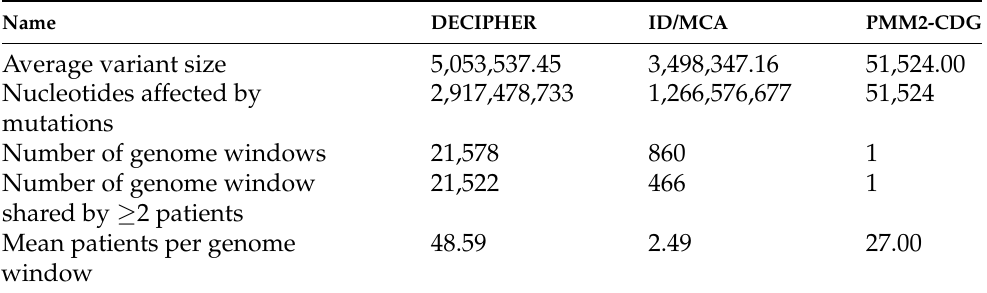
Table 6. Cohort Analyzer general summary statistics. The information listed in this table refers to the patients phenotyped with at least three HPO terms and with characterized genomic